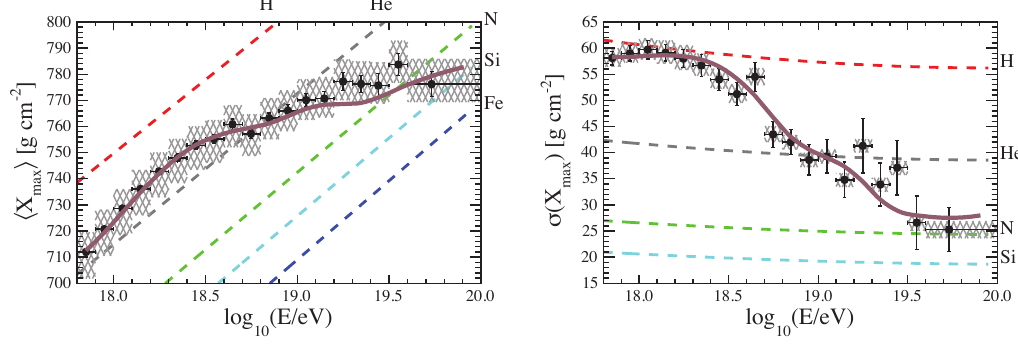
Figure 3. First two moments of the X max distributions as predicted by the best-fit results in S cenario 1, along with the measured values and the predictions for pure compositions of various nuclear species according to E pos -LHC (dashed